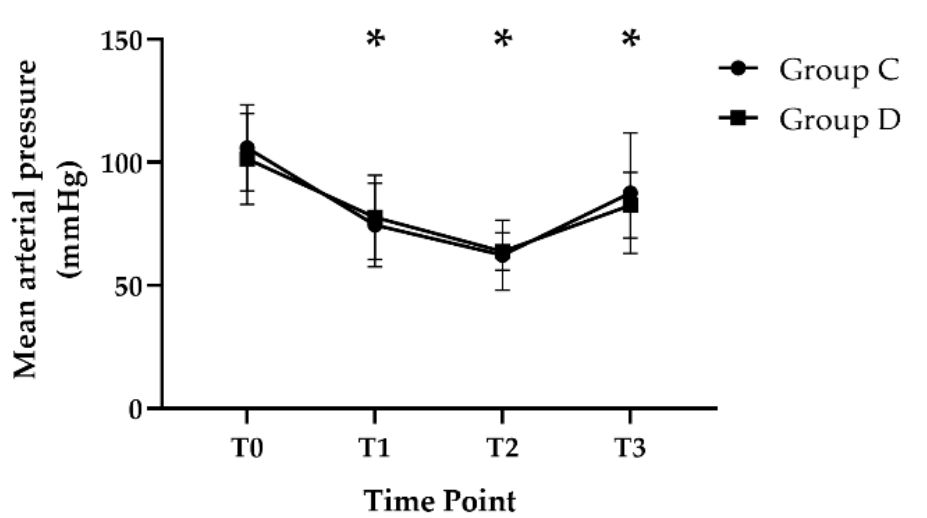
Figure 2. Change in mean arterial pressure during the study period. Error bars represent standard